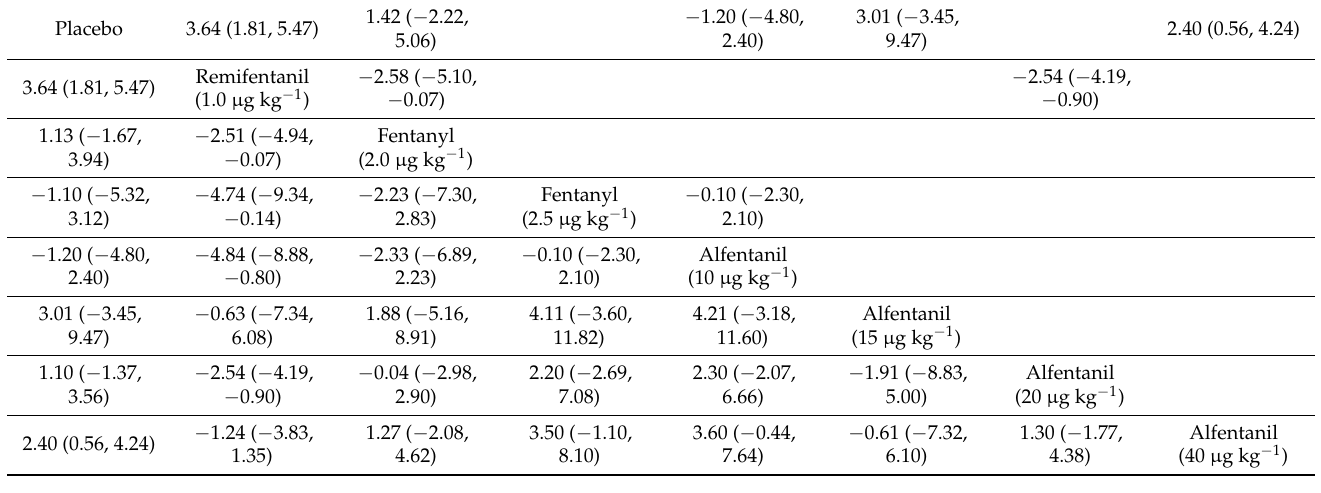
Table 4. The comparative efficacy of treatments on the intraocular pressure measured after the administration of succinylcholine.